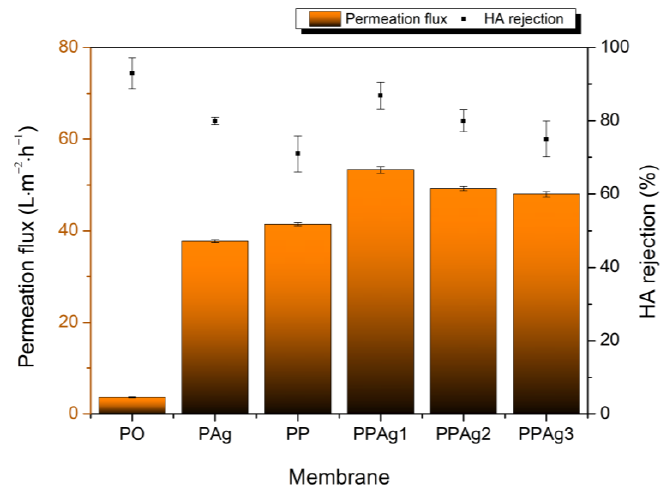
Figure 8. Membrane selectivity performance.